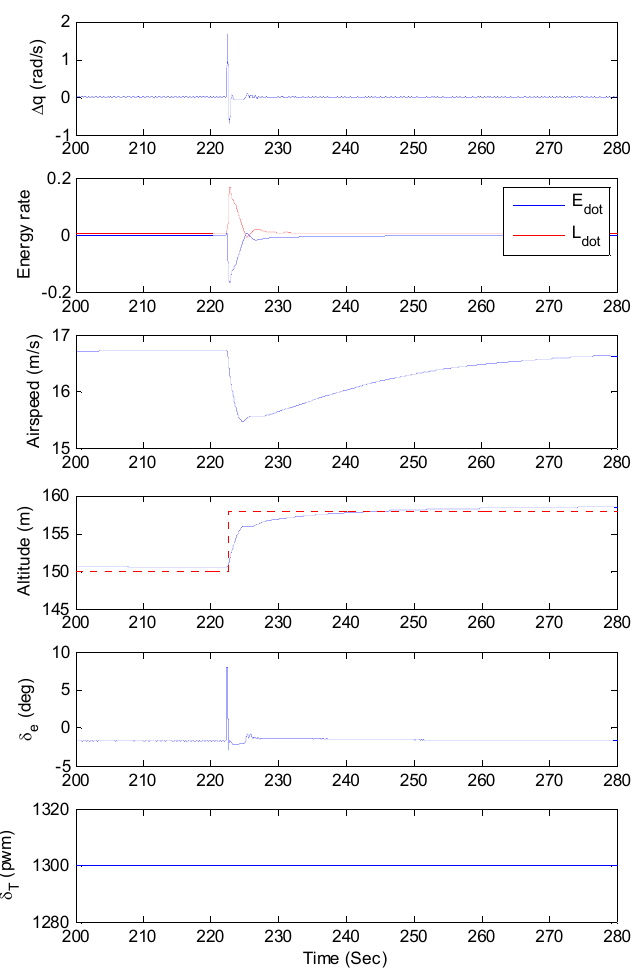
Figure 19. Fuzzy logic control (FLC) simulation results of climbing without the presence of wind.